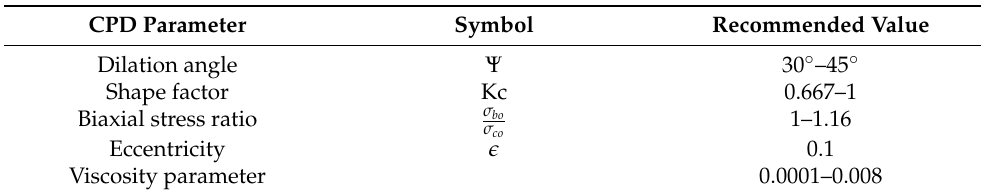
Figure 6. The uniaxial compressive and tensile stress-inelastic strain relationship for concrete according to the CDP constitutive model. ( a ) Concrete in compression. ( b ) Concrete in tension. Table 1. CPD model key parameters.